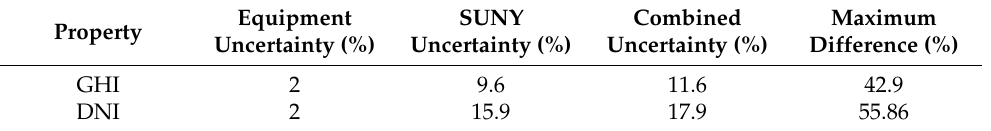
Figure 8. Correlation of satellite-modeled DNI with ground-based DNI. Table 5. Comparison of uncertainties and maximum differences in GHI and